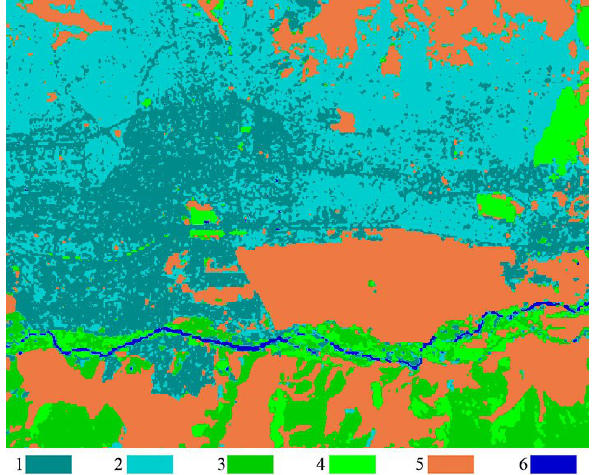
Figure 4. Classification result obtained by the rule-based classification. (1-builtup area; 2-ger area; 3-forest; 4-grass; 5-soil;